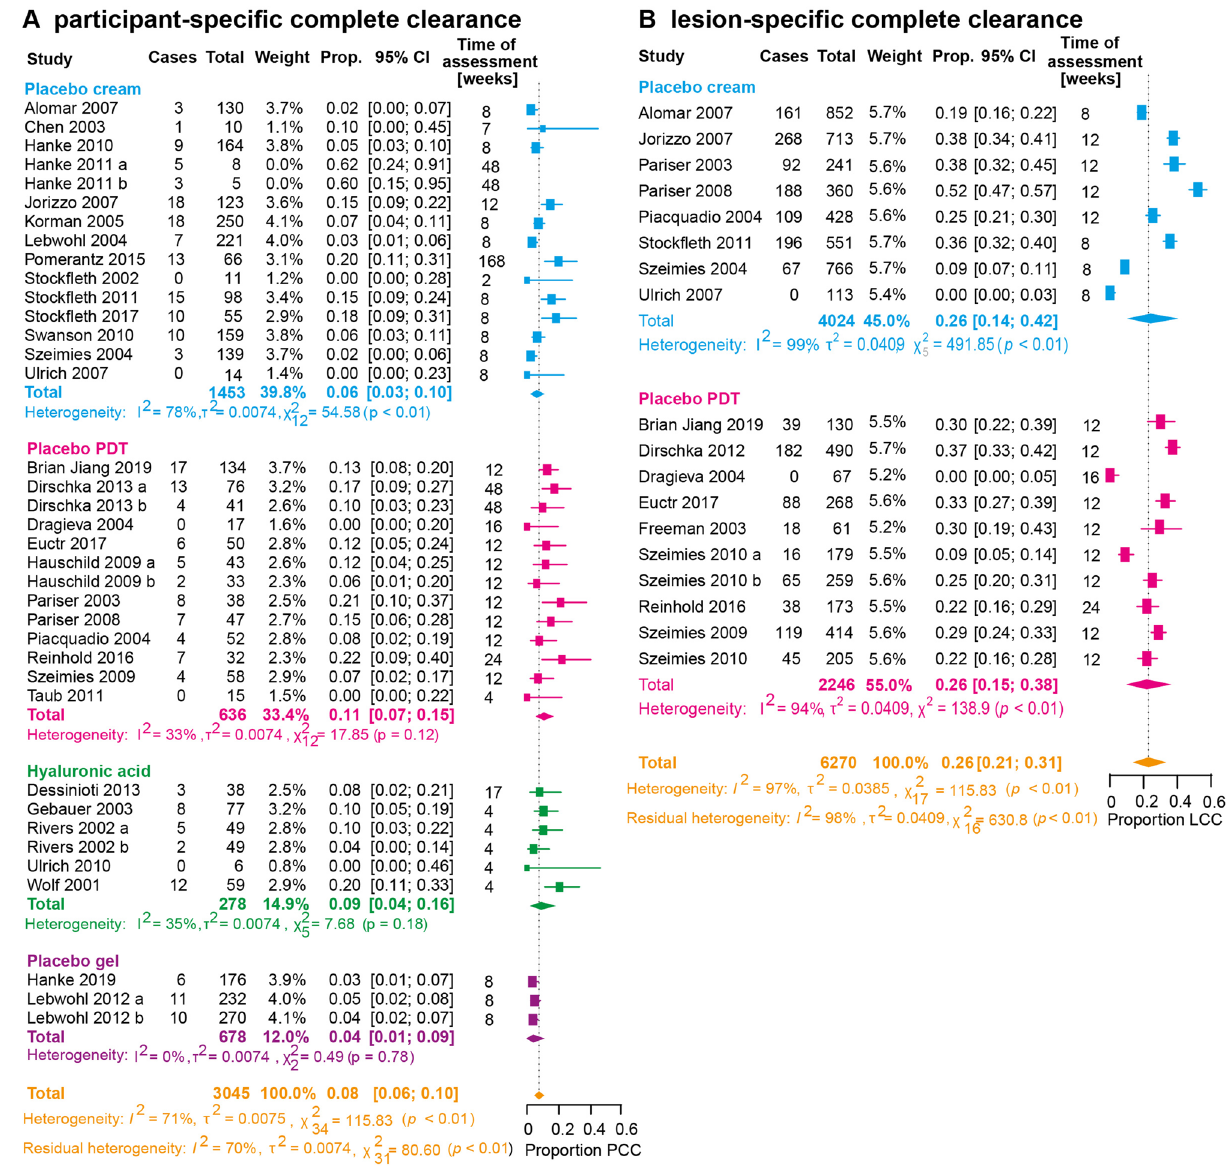
Figure 1. ( A ) Forest plot examining the pooled proportion of the adjusted overall participant-specific complete clearance (PCC) rate for the different types of placebos. Outliers have been excluded. ( B ) Forest plot examining the pooled proportion of the adjusted overall lesion-specific complete clearance rate and the lesion-specific clearance rate for the different types of placebos. In all cases, forest plots examining single-armed trials are shown. Random-effects analysis was used. The diamond represents the estimate from the study. The width of the line extending from each diamond represents the 95% confidence interval (CI). Prop.: